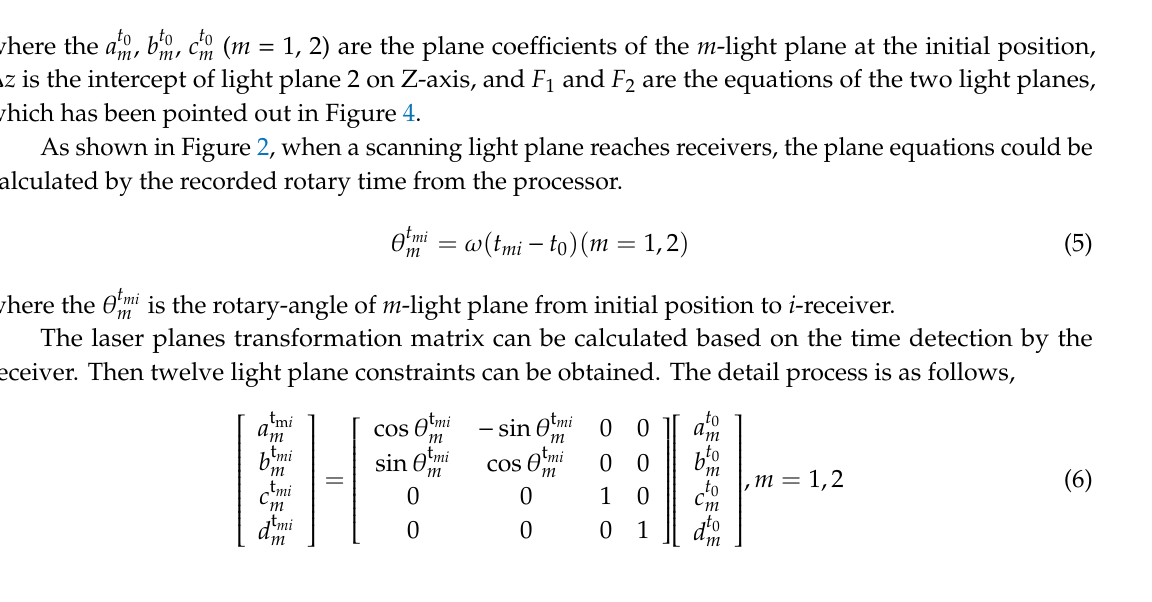
Figure 4. Principle of the guidance system based on rotary-laser scanning technology. Six receivers and a retroreflector with the fixed position are placed on the target in our experiment, the target is shown in Figure 4. Two light planes start from the initial position and pass through each receiver in turn during